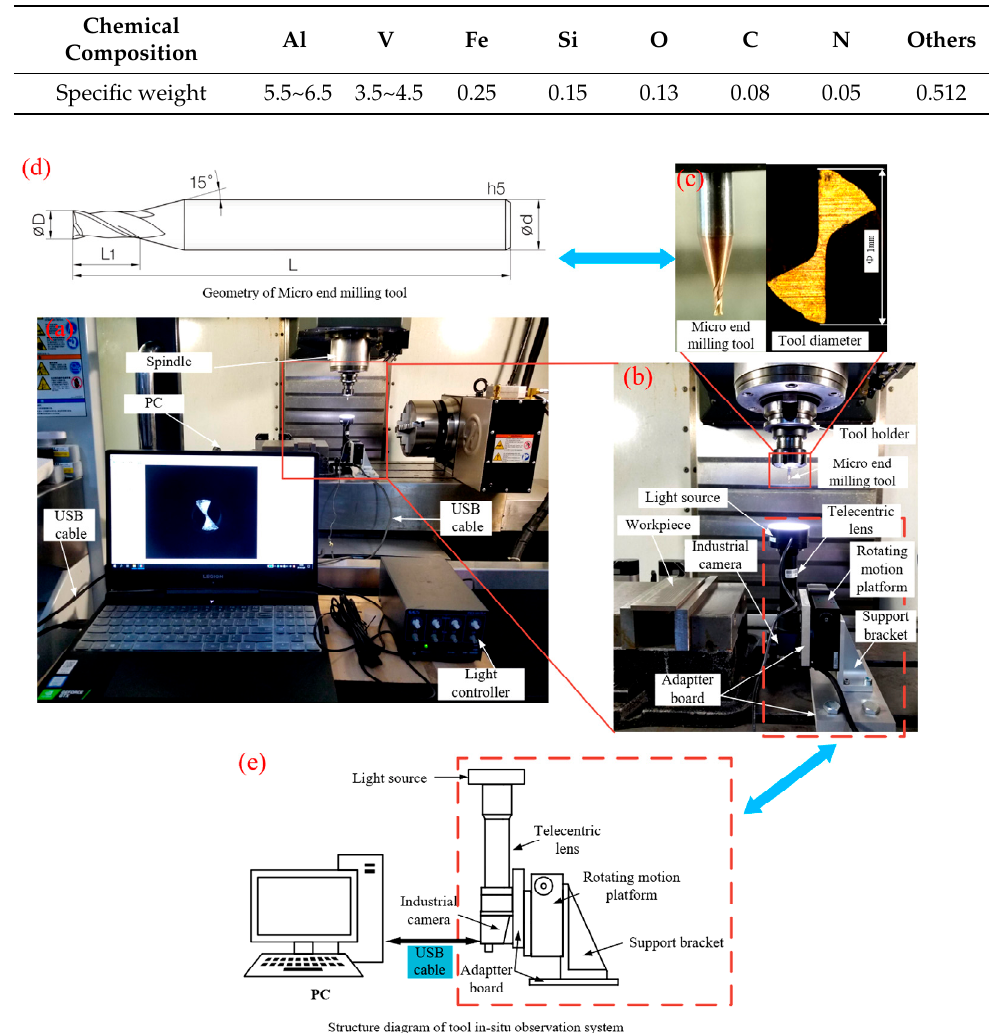
Table 1. Chemical Composition of Ti6Al4V.